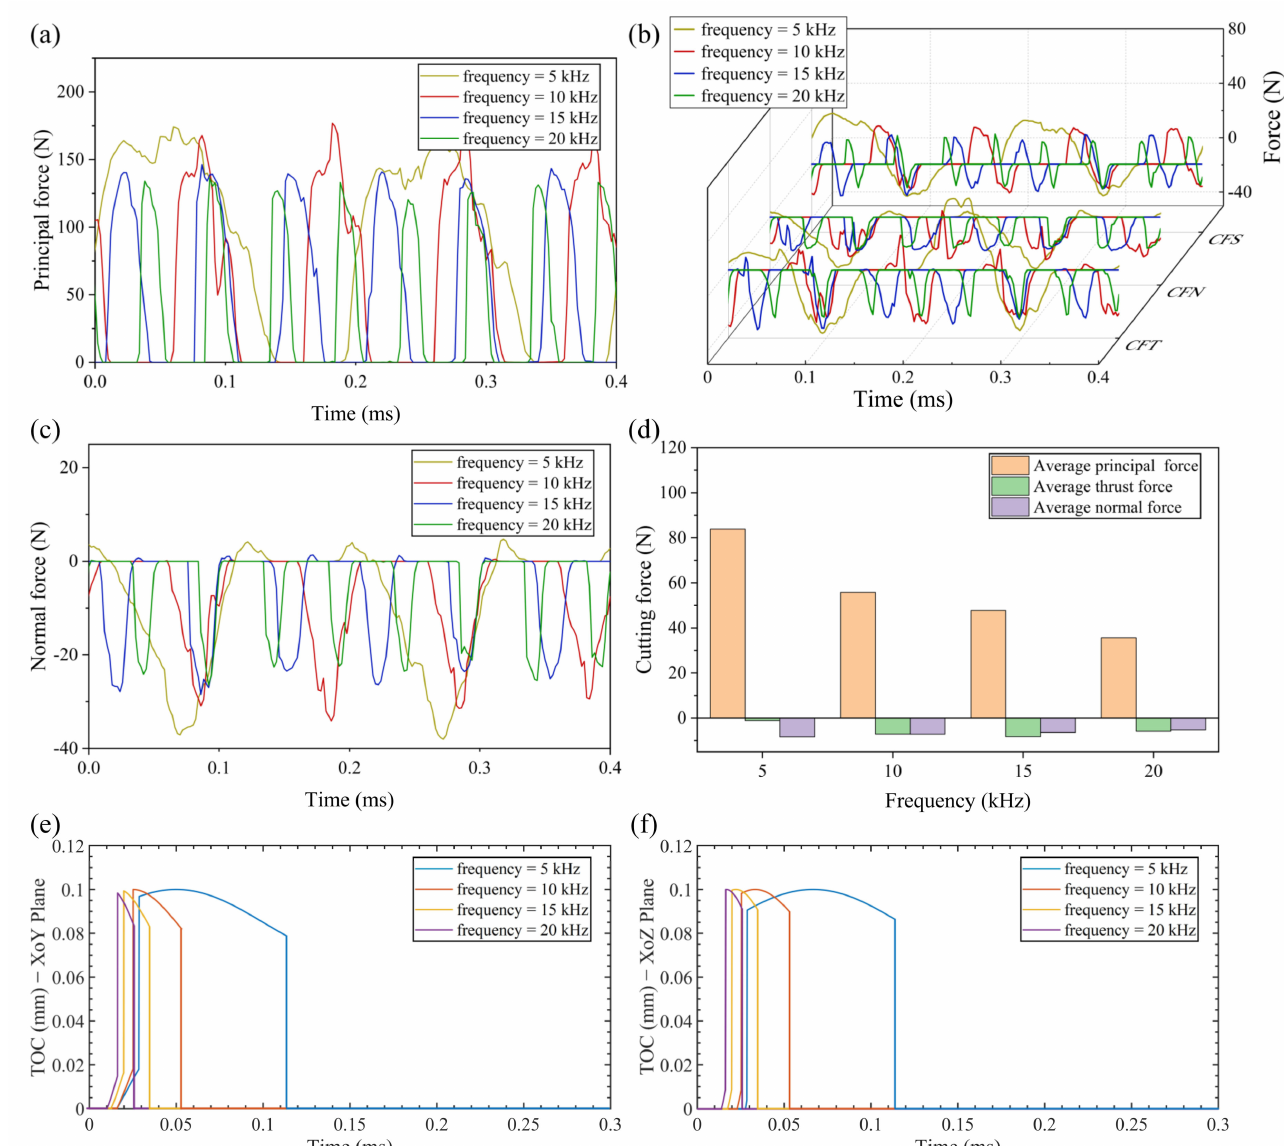
Figure 9. Results of cutting force and TOC with various vibration frequencies ( a ) principal force ( b ) thrust force ( c ) normal force ( d ) average cutting force ( e ) TOC with various vibration frequencies in XoY plane ( f ) TOC with various vibration frequencies in XoZ